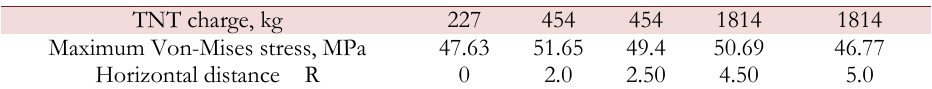
Table 9: The maximum Von-Mises stress with different vehicle charges and at different horizontal distances. C